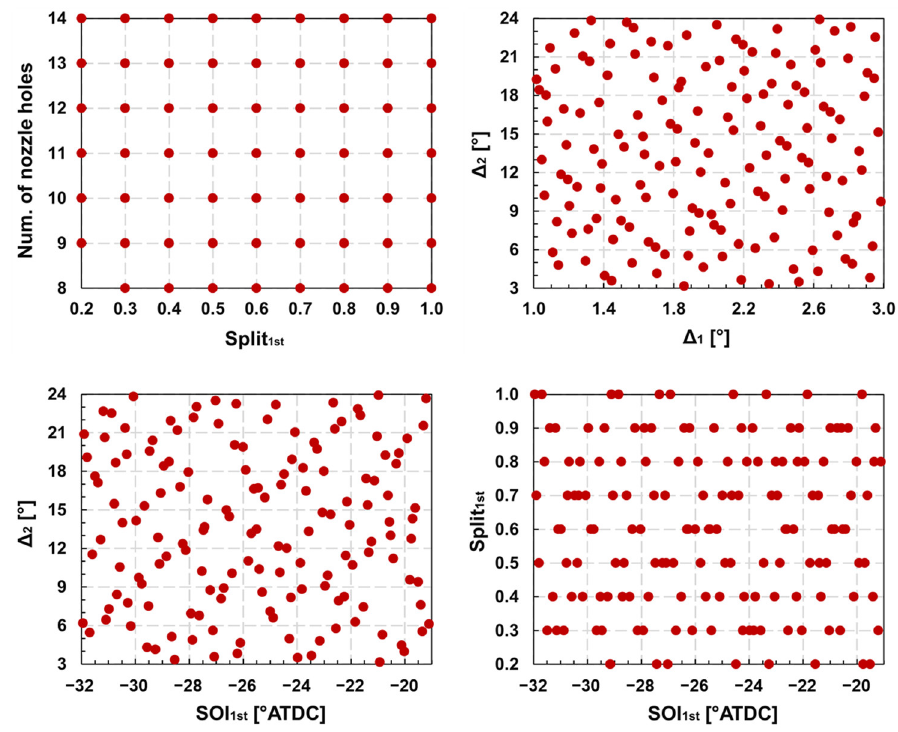
Figure 4. Design points selected by using the Sobol sequence space-filling method.